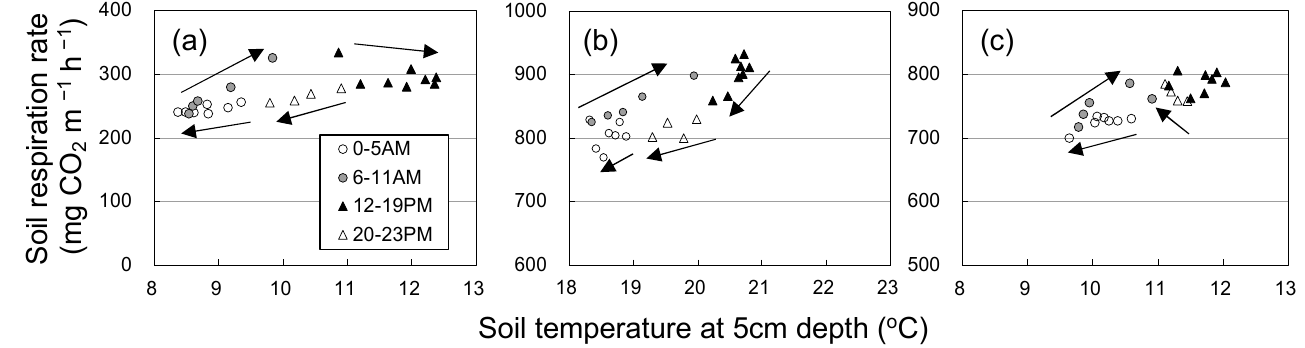
Figure 3. Relationship between daily mean soil respiration rate and daily mean soil water content (SWC) at a depth of 10 cm in the three seasons in 2018. Closed black circles, open gray triangles, and closed gray circles were data in spring, summer, and autumn.